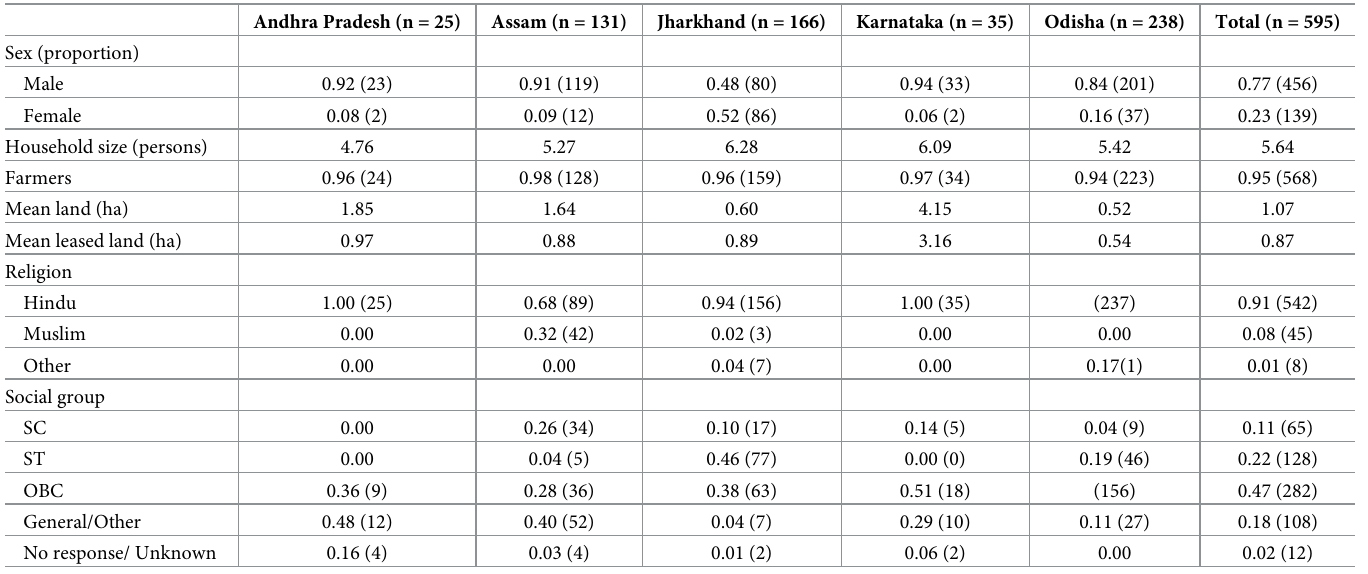
Table 1. Select farm and household characteristics, means with the number of observations in